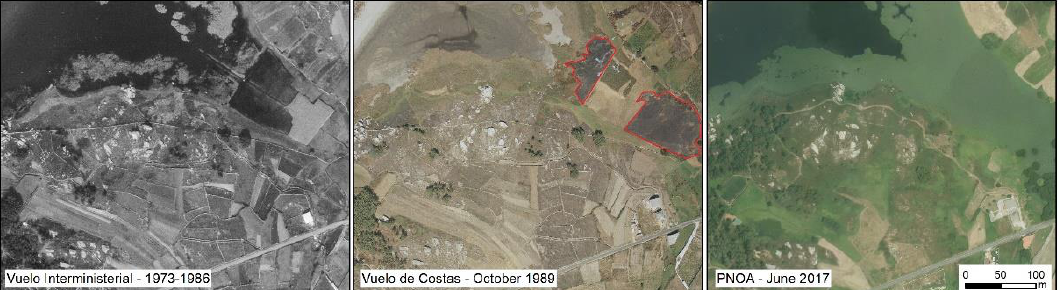
Figure 6. Evolution of Vixan lagoon SE sector. From left to right the images correspond with Interministerial flight (1973–1986); Coastal flight in October 1989 and PNOA image in June 2017. Data: (IGN, [20]). Red polygons in 1989 represents burnt reedbed. The burning in this lagoon part was frequent at the end of summer.